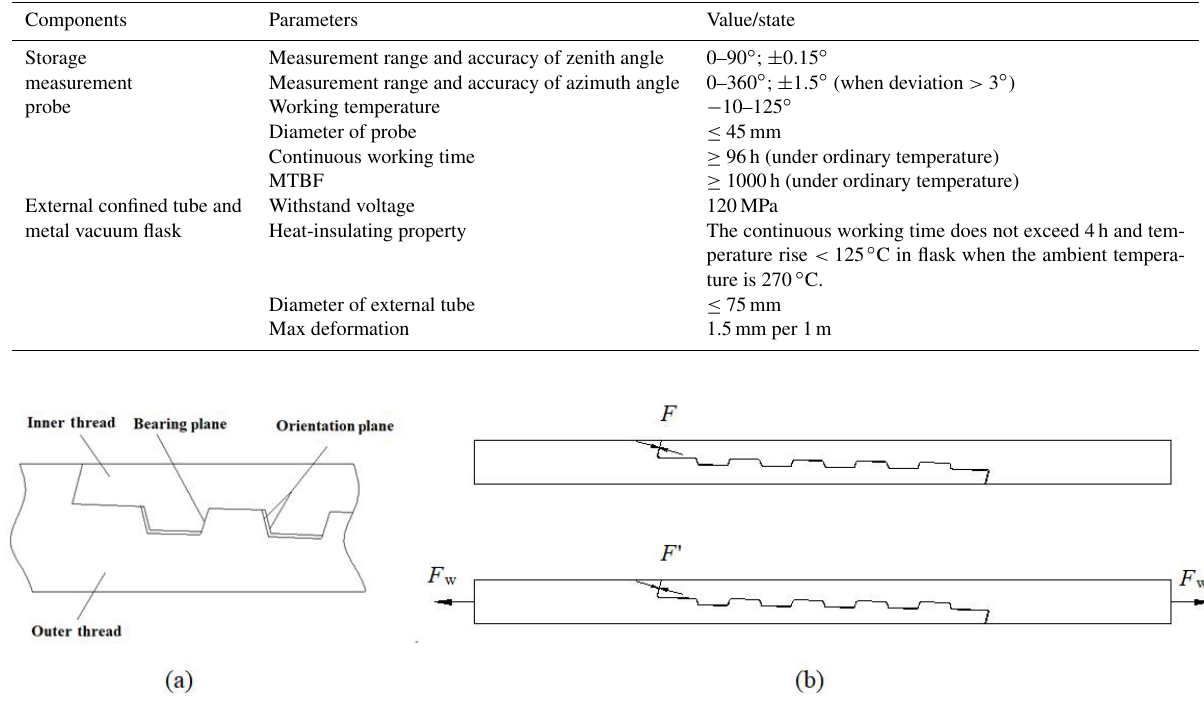
Figure 8. (a) Diagram of internal and external thread matching; (b) effect of axial load on pre-load.